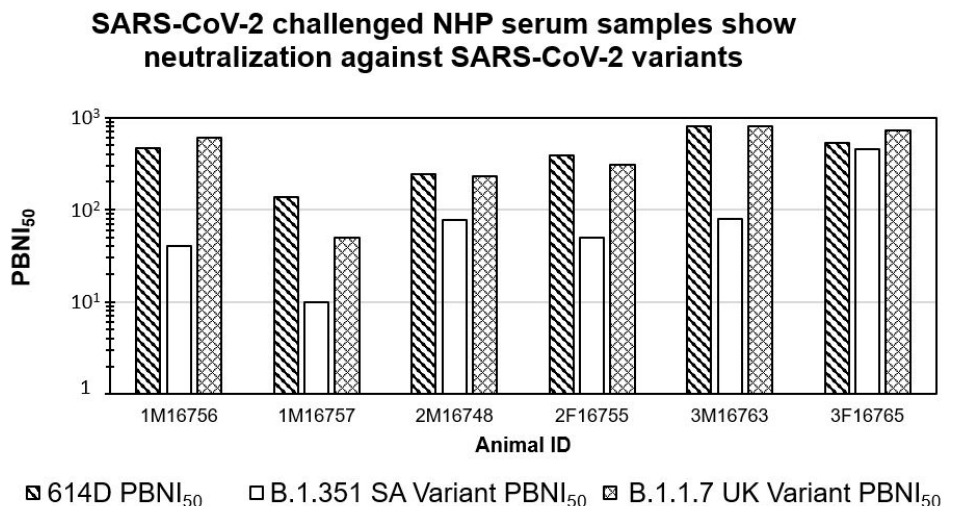
Figure 2. Reproducibility of the SARS-CoV-2 spike protein pseudovirus-based neutralization assay: PBNA for 6 serum samples from SARS-CoV-2-challenged NHP, 2 positive and 1 unchallenged NHP controls was conducted in two independent experiments (11 and 18 June 2021). Log transformed PBNI 50 from each experiment is plotted on the X - and Y -axis, respectively. The correlation of R 2 = 0.96, with the trend line between the PBNI 50 from both the experiments, is shown by the dotted line in the figure.